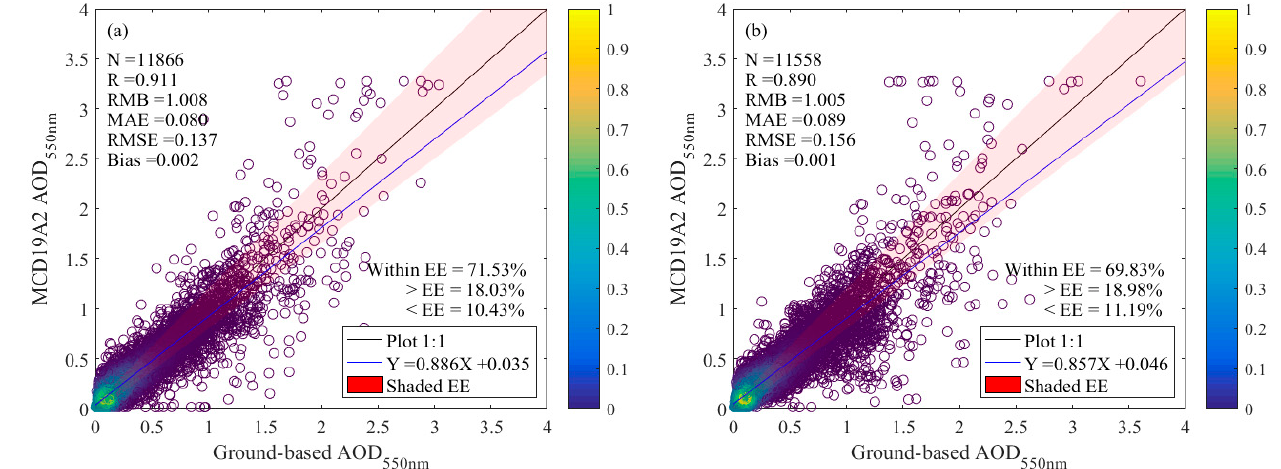
Figure 2. Overall accuracy of MAIAC AOD. ( a ) MAIAC Terra vs. AERONET, ( b ) MAIAC Aqua vs. AERONET.